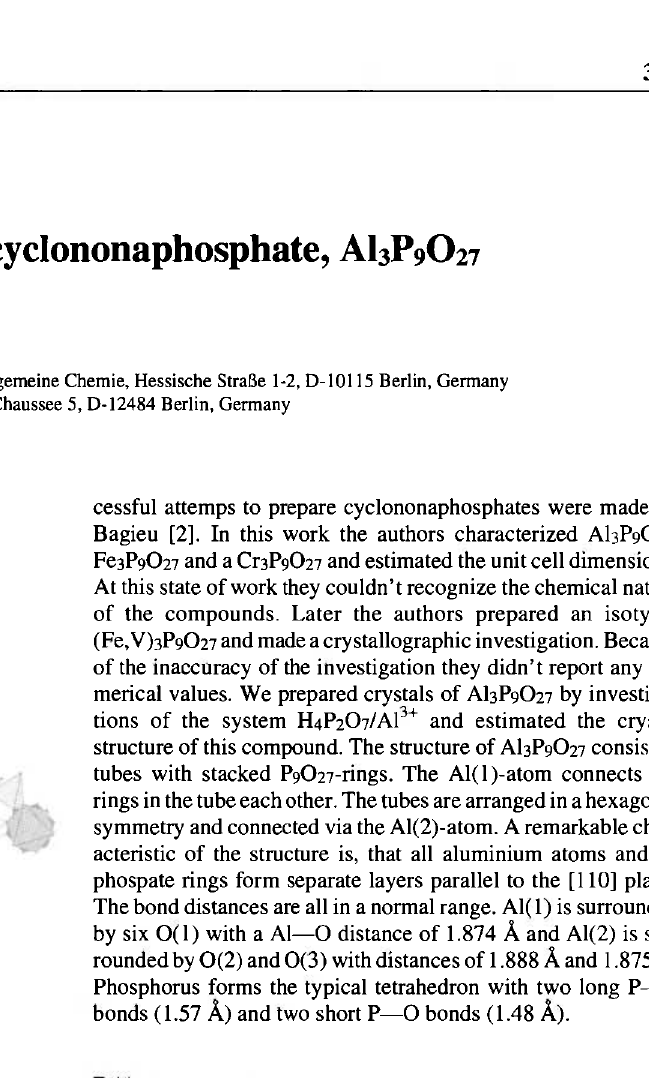
Table 1. Data collection and handling.